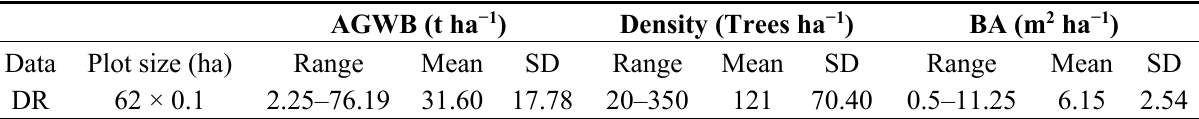
Table 2. Summary of the plots that were collected in the denser woodland areas of Deep River